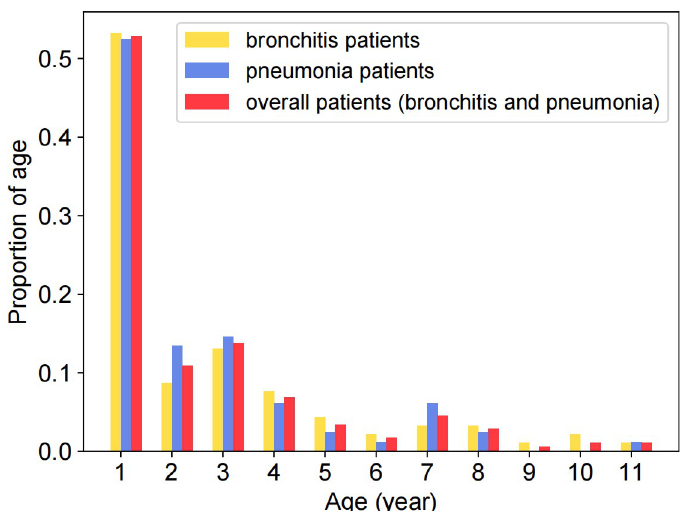
Fig 2. Age distributions of bronchitis, pneumonia, and all